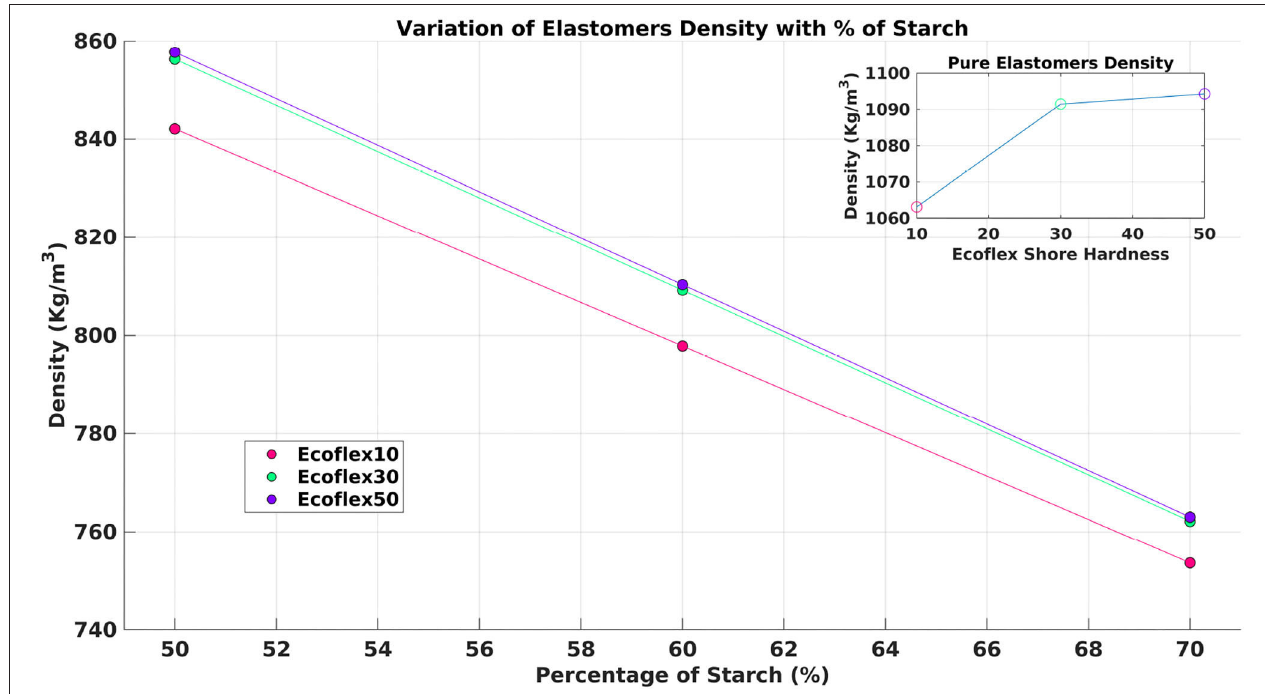
FIGURE 6 | Variation of density in the elastomers depending from the percentage of starch. The more starch is in the blend the lower is the density of the resulting material. The inset shows the density of the pure elastomers vs. their shore hardness, i.e., resistance to indentation.